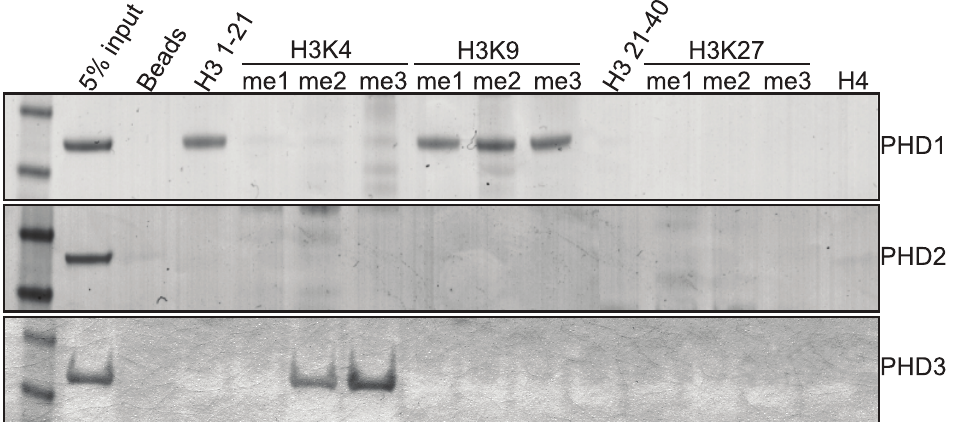
Figure 5. The PHD fingers of Lid bind specific forms of methylated histone tails. GST fusion proteins of Lid’s PHD1 (top panel), PHD2 (2 nd panel) and PHD3 (3 rd panel) were tested for binding to biotinylated histone peptides of histone H3 amino acids 1–21, 21–44 and histone H4 1–21. In addition, peptides mono, di or tri methylated at histone H3 K4, K9 and K27 were also tested for their ability to bind these PHD fingers.